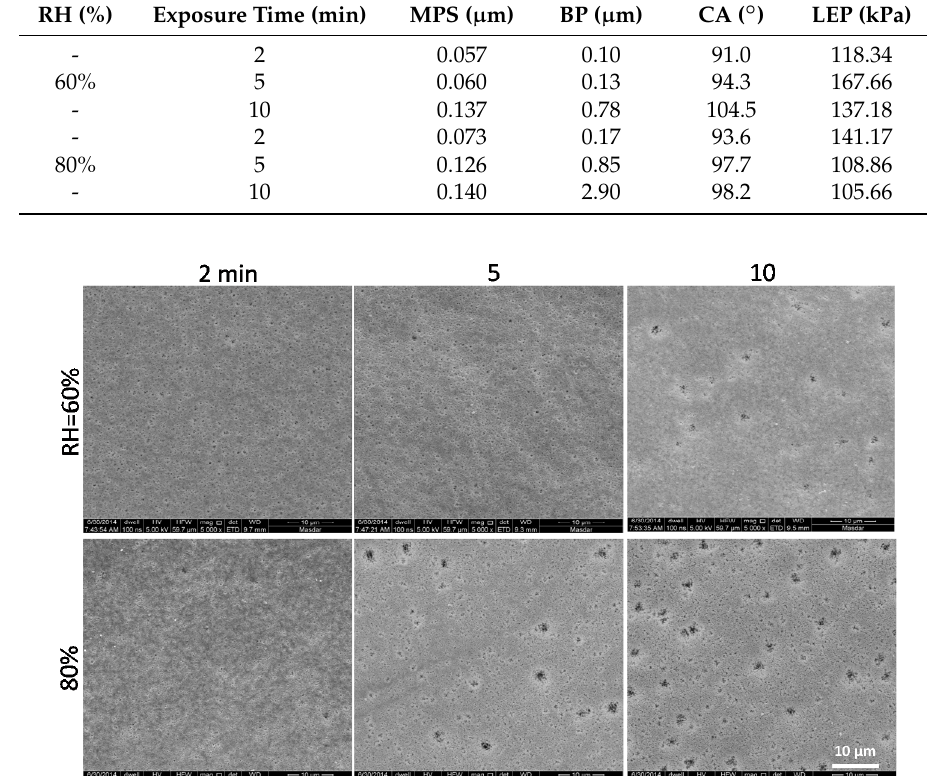
Figure 5. Surface SEM images of membrane samples prepared under different RH and different exposure times. Casting thickness: 500 μ m, polymer solution: 12% w / w PVDF.